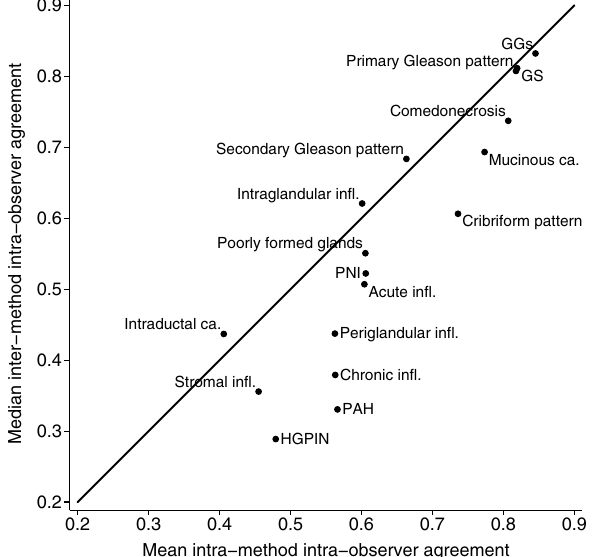
Figure 3. Interchangeability plot for all characteristics evaluated on the core and slide level (median inter- method intra-observer agreement vs. mean intra-method intra-observer agreement). Note: Median inter- method intra-observer agreement refers to the median of the agreements between the Reviewer 1.1 on LM vs. VM, Reviewer 1.2 on LM vs. VM and Reviewer 2 on LM vs. VM. Mean intra-method intra-observer agreement refers to the mean of the agreements between the Reviewer 1.1 vs. Reviewer 1.2 on LM and on VM. LM, light microscopy; VM virtual microscopy; GGs Gleason Grade Groups; GS, Gleason score; PNI Perineural invasion; PAH Postatrophic hyperplasia; HGPIN High-grade prostatic intraepithelial neoplasia; infl Inflammation; ca